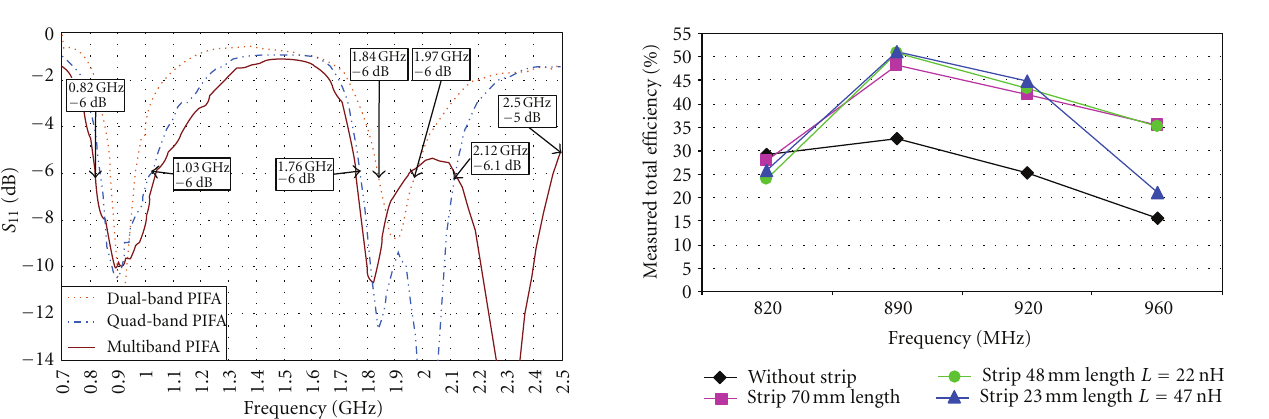
F 26: Measured re�ection coefficient for the three studied prototypes. It can be seen how the proposed multiband design can operate at least over the GSM850, GSM900, DCS, PCS, UMTS, and Bluetooth bands.